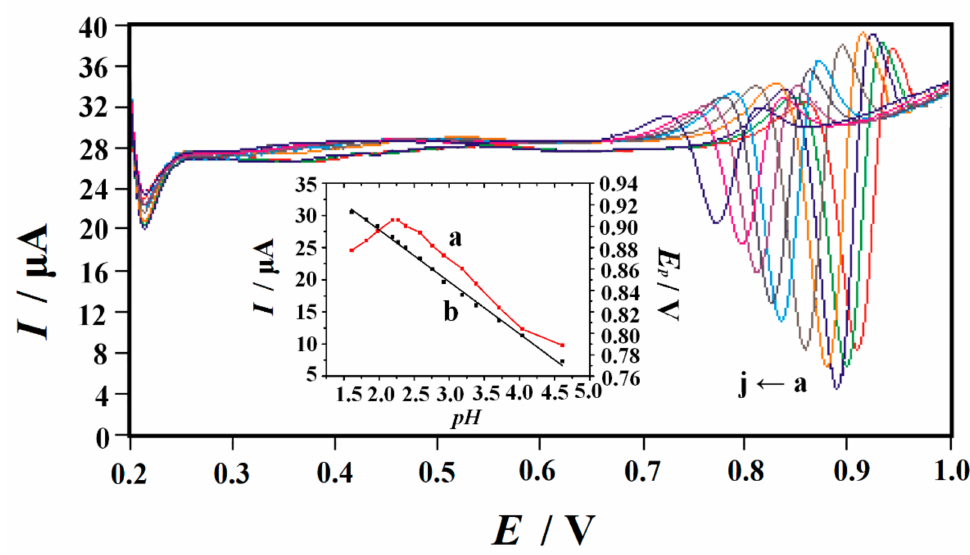
Figure 6. SDLSVs of 10 µ M Trp at PVP-GR / GCE in 0.1 M PBS with di ff erent pH values a–j: 1.61, 1.98, 2.20, 2.38, 2.76, 3.18, 3.38, 3.71, 4.04 and 4.61, respectively. Inset: ( a ) the relationship between the peak